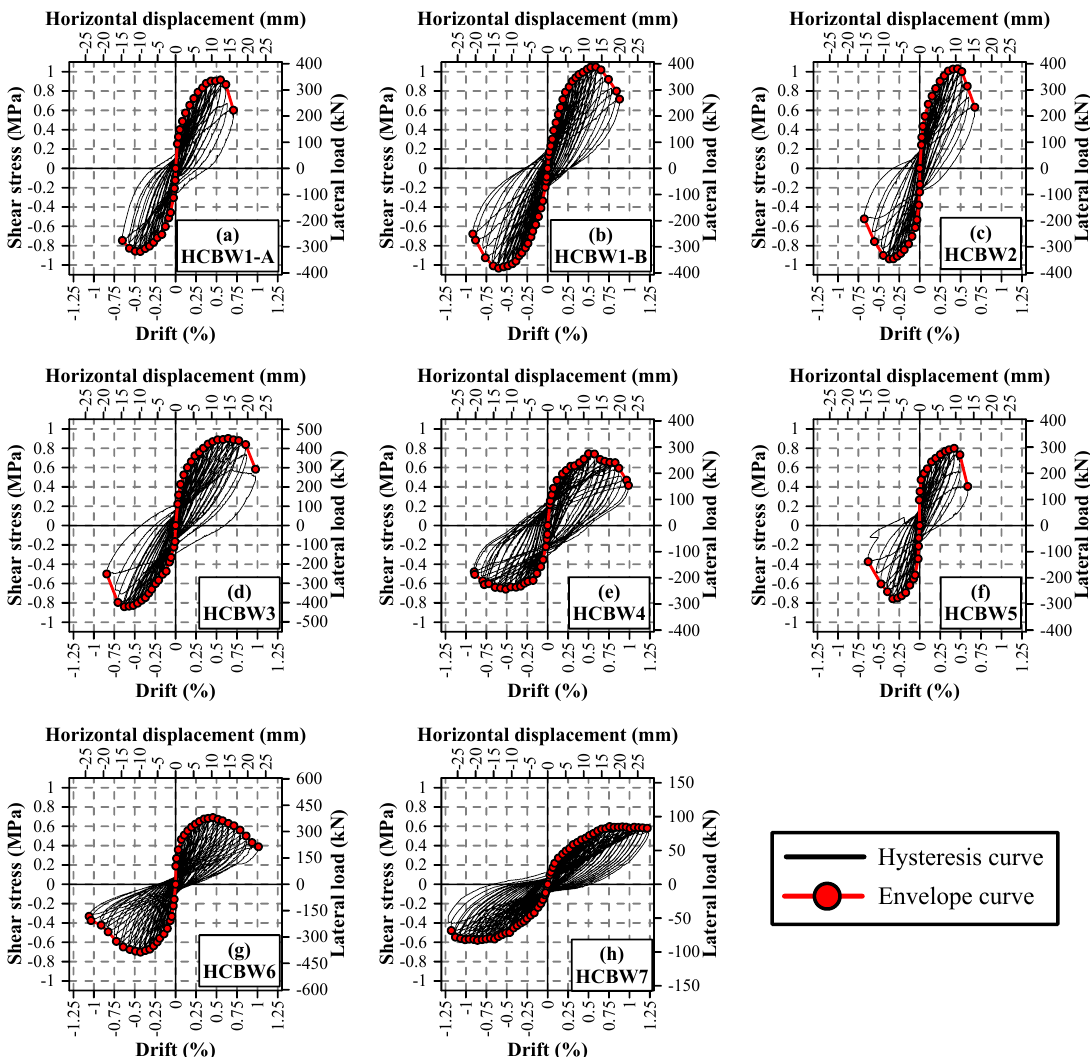
Figure 6. Hysteresis curves of tested walls: ( a ) wall HCBW1-A, ( b ) wall HCBW1-B, ( c ) wall HCBW2, ( d ) wall HCBW3, ( e ) wall HCBW4, ( f ) wall HCBW5, ( g ) wall HCBW6, and ( h ) wall